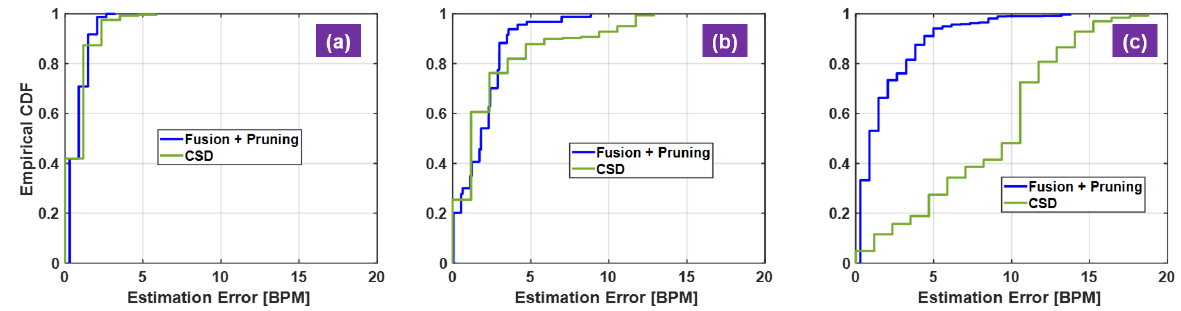
Figure 6. Heart-rate (HR) estimation error analysis from different poses. Blue curve denotes the proposed method using sensor fusion with spectral peak pruning algorithm and green curve the complex signal demodulation method (CSD).